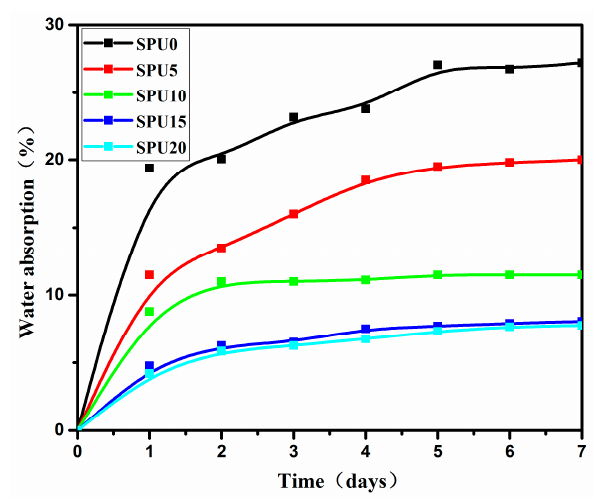
Figure 16. Water absorption of SPU films as a function of time in days.